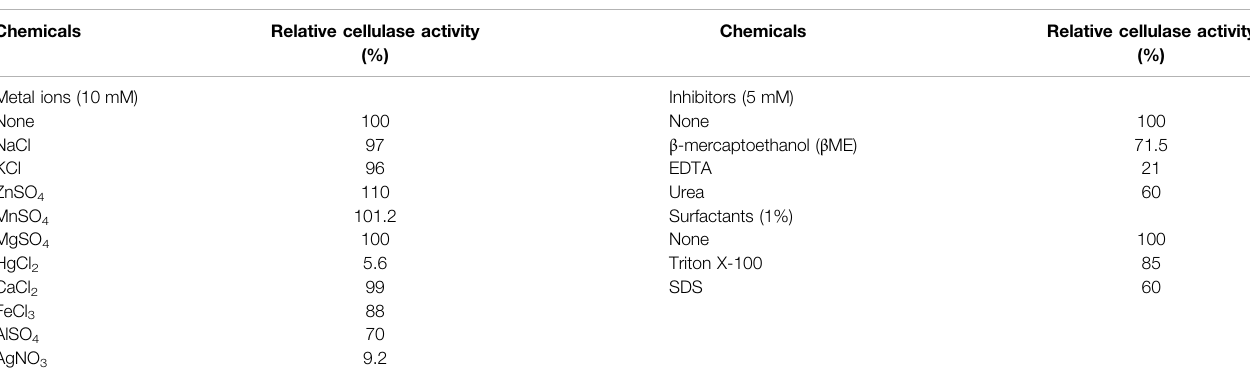
TABLE 3 | Effect of modulators on the activity of B. subtilis CD001 cellulase.